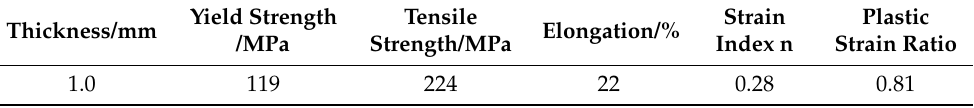
Table 1. Mechanical properties of material AL6061-T6.